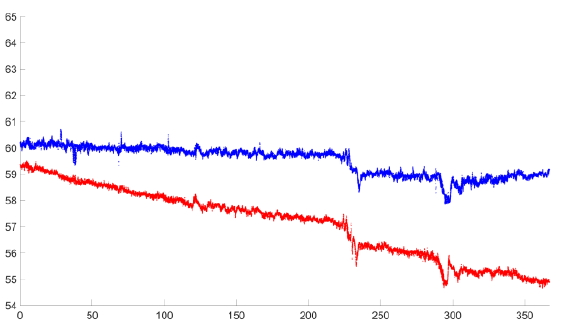
Figure 5. East-West profiles, 1 m thick, for Blocks 3 (blue line) and 4 (red line); significant z-shift and rotation are evident